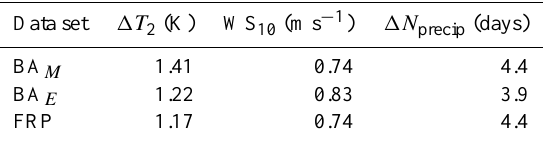
Table 2. Mean values of the standard deviations calculated from the nearest neighbours search ( (cid:49)T 2 , WS 10 and (cid:49)N precip ).